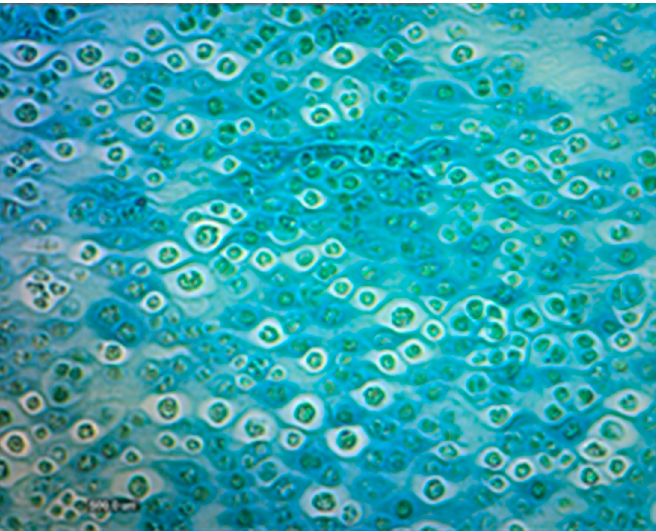
Figure 8. Dictyosphaerium chlorelloides cells stained with Alcian blue in a 6-fold diluted medium. The EPS are visualized in blue color as capsules of EPS around the cells (4000×).